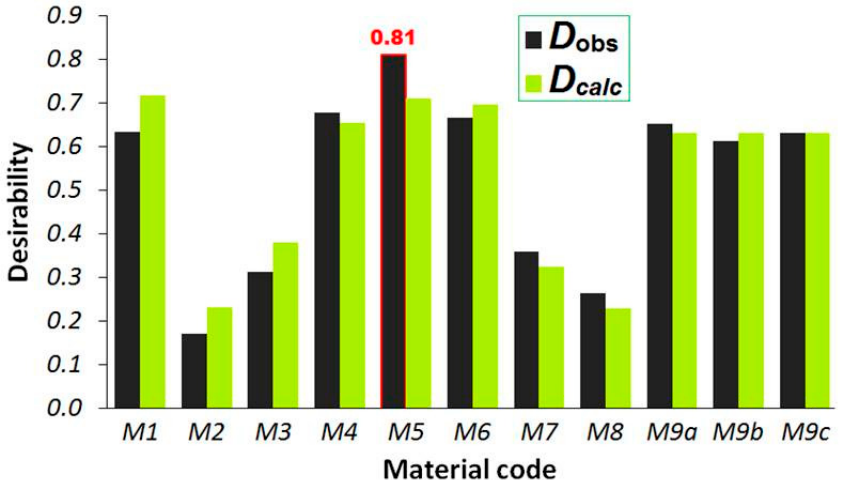
Figure4. Globaldesirabilityvaluesattributedtoeachmaterialsample(observedvaluesvs. Figure 4. Global desirability values attributed to each material sample (observed values vs. calculated values).